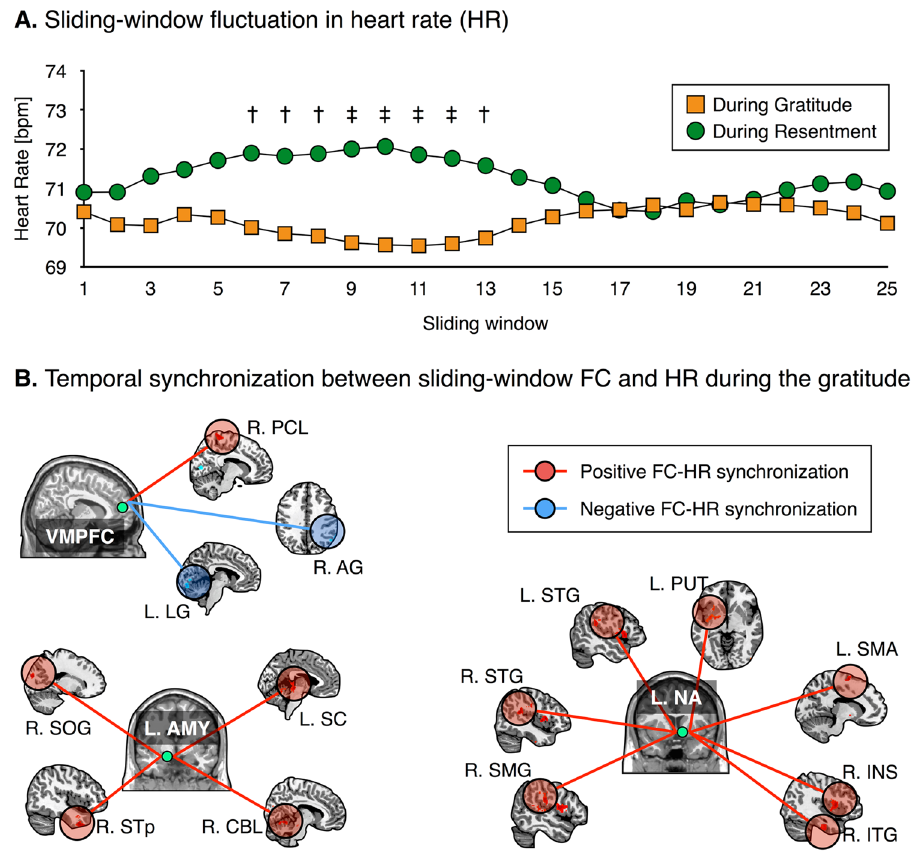
Figure 1. Sliding-window fluctuations in heart rate (HR) ( A ) and temporal synchronization between dynamic functional connectivity (FC) and HR during the gratitude intervention ( B ). Dagger (†) and double dagger (‡) in an inset ( A ) indicate for the significant paired sample t-test results at each sliding-window with different thresholds of P < 0.05 and P < 0.005, respectively. Peak coordinates of each cluster and statistical values are summarized in Supplementary Table S3. Abbreviations: AG, angular gyrus; bpm, beat per minutes; CBL, cerebellum; INS, insula; ITG, inferior temporal gyrus; L, left; LG, lingual gyrus; PCL, paracentral lobule; PUT, putamen; R, right; SC, superior colliculus; SMA, supplementary motor area; SMG, supramarginal gyrus; SOG, superior occipital gyrus; STG, superior temporal gyrus; STp, superior temporal pole; VMPFC, ventromedial prefrontal